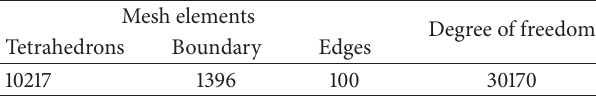
Table 2: Measured values of thermal conductivity ( 𝜆 ), volumetric heat capacity (VHC), and electrical conductivity ( 𝜎